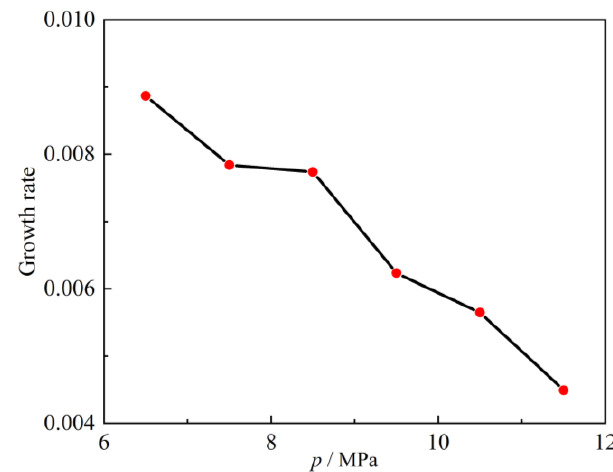
Figure 18. Growth rate curve with environmental pressure increases from 6.5 MPa to 11.5 MPa.